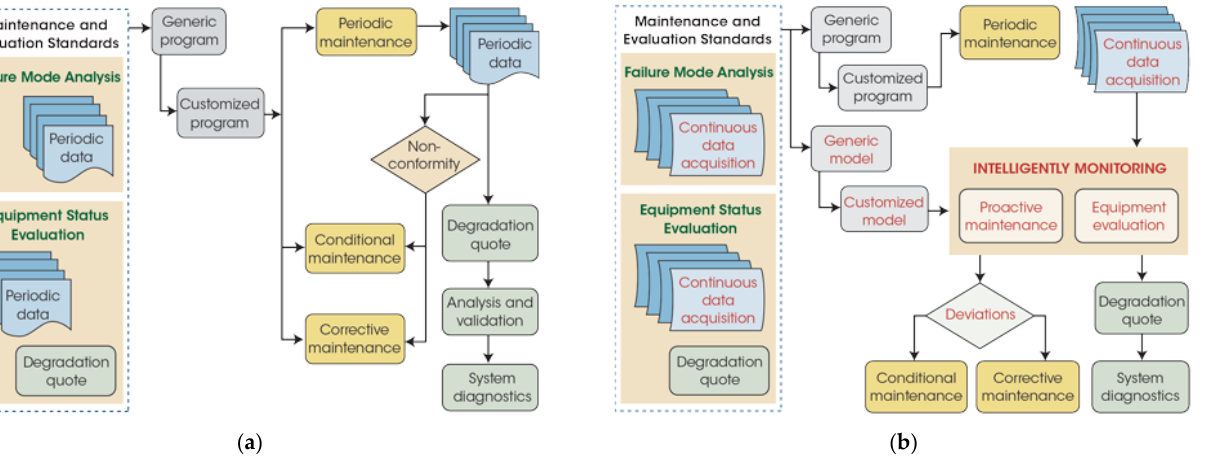
Figure 15. Strategy of intelligent maintenance based on monitoring linked to system diagnostic and maintenance program [105]: ( a ) traditional maintenance program methodology with accent on periodic activities; ( b ) in red the elements of the recommended intelligent maintenance method taking advantage of the recording, analysis and modeling capabilities of current computer systems, which allow much higher proactivity.